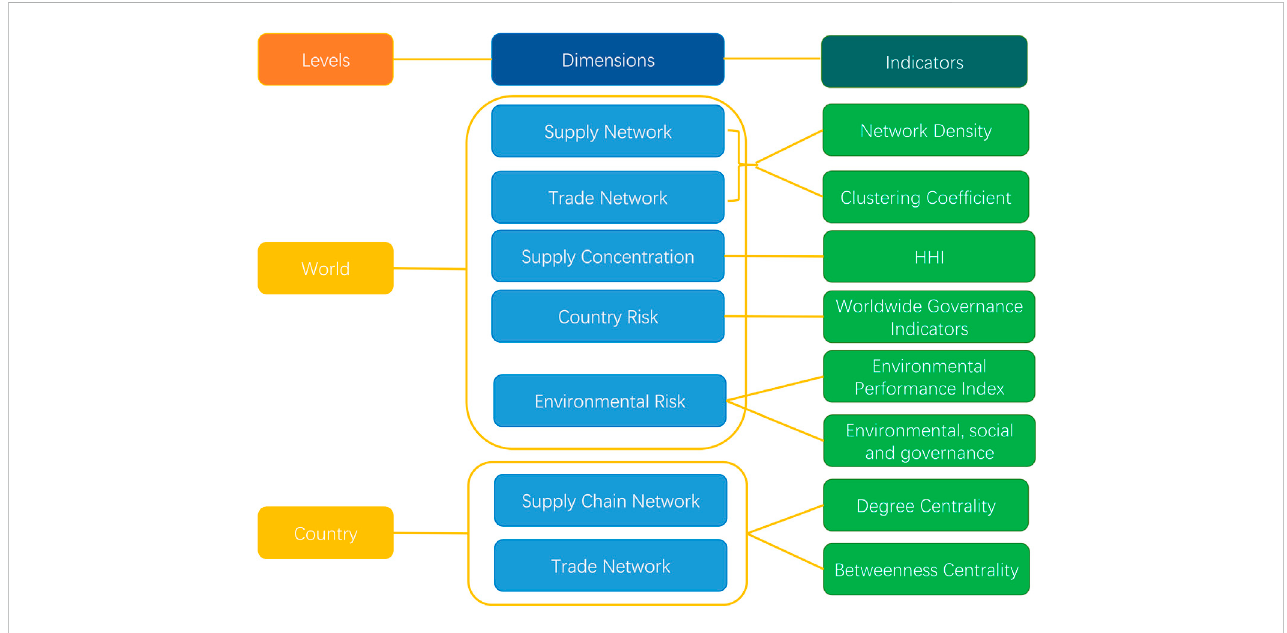
The global platinum supply chain risk assessment